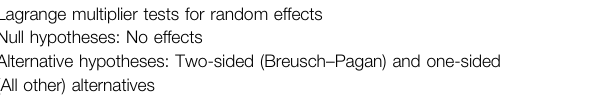
TABLE 3 | Breusch – Pagan test / Source: Own calculation using EViews 11. Lagrange multiplier tests for random effects Null hypotheses: No effects